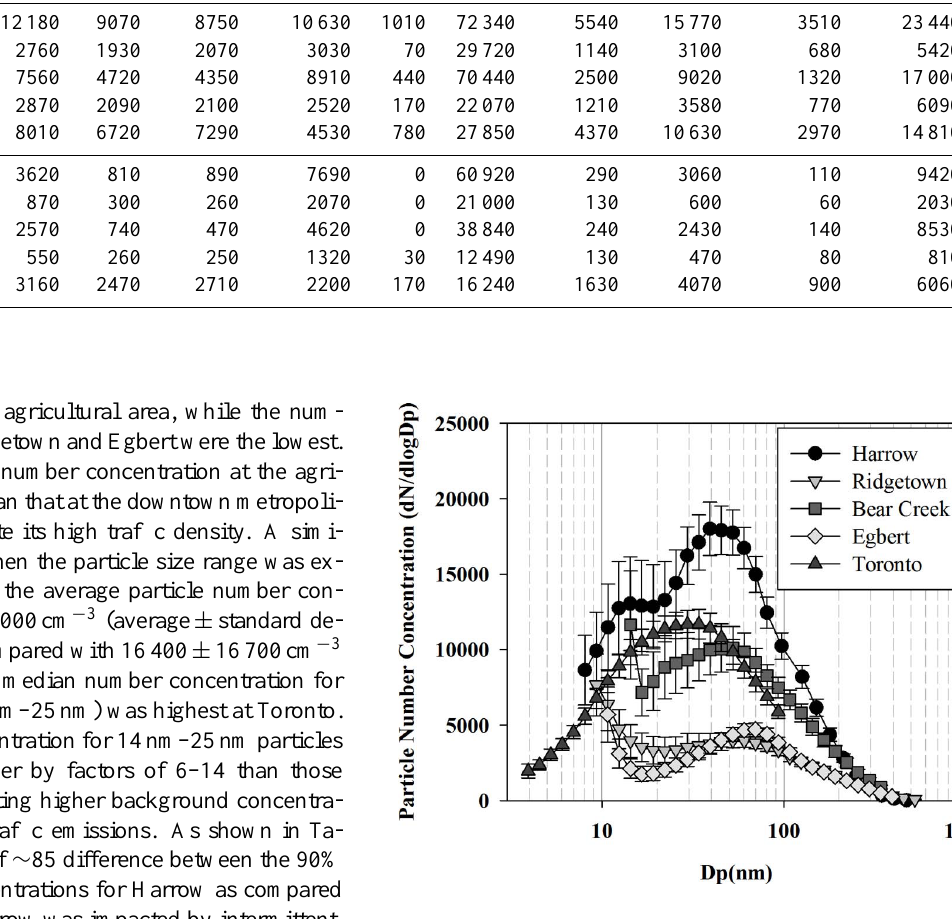
Toledo, Ohio and ∼ 60 km southwest of the Harrow site were possible sources of these slightly aged ( < ∼ 2 h) particles in the Harrow